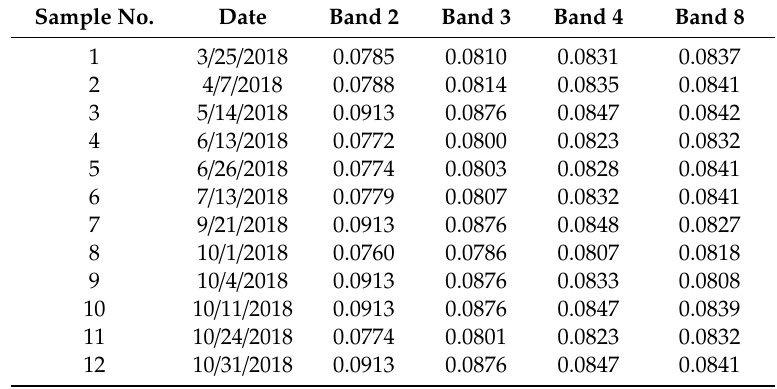
Table 9. The weight coe ffi cients for 12 calibration samples in bands 2, 3, 4, and 8 of Sentinel-2B / MSI. Sample No.